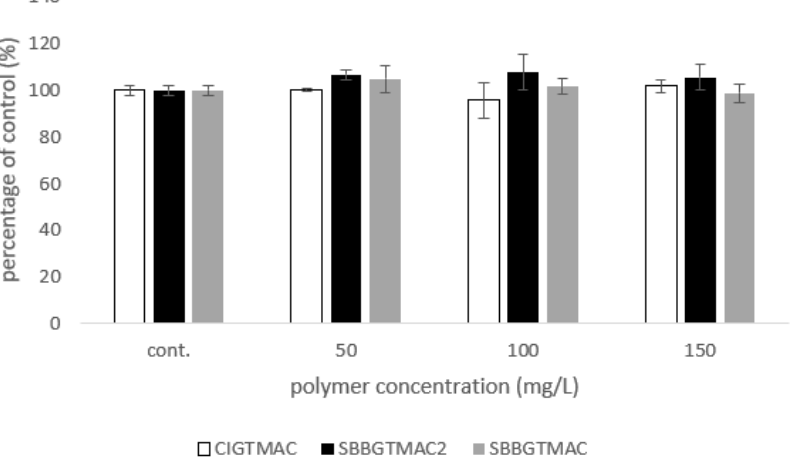
Figure 1. Preliminary toxicity studies of the obtained polycations using the 3T3-L1 fibroblast cell line. In the experiment, serum-free DMEM medium was used; exposure to the polymer lasted for 24